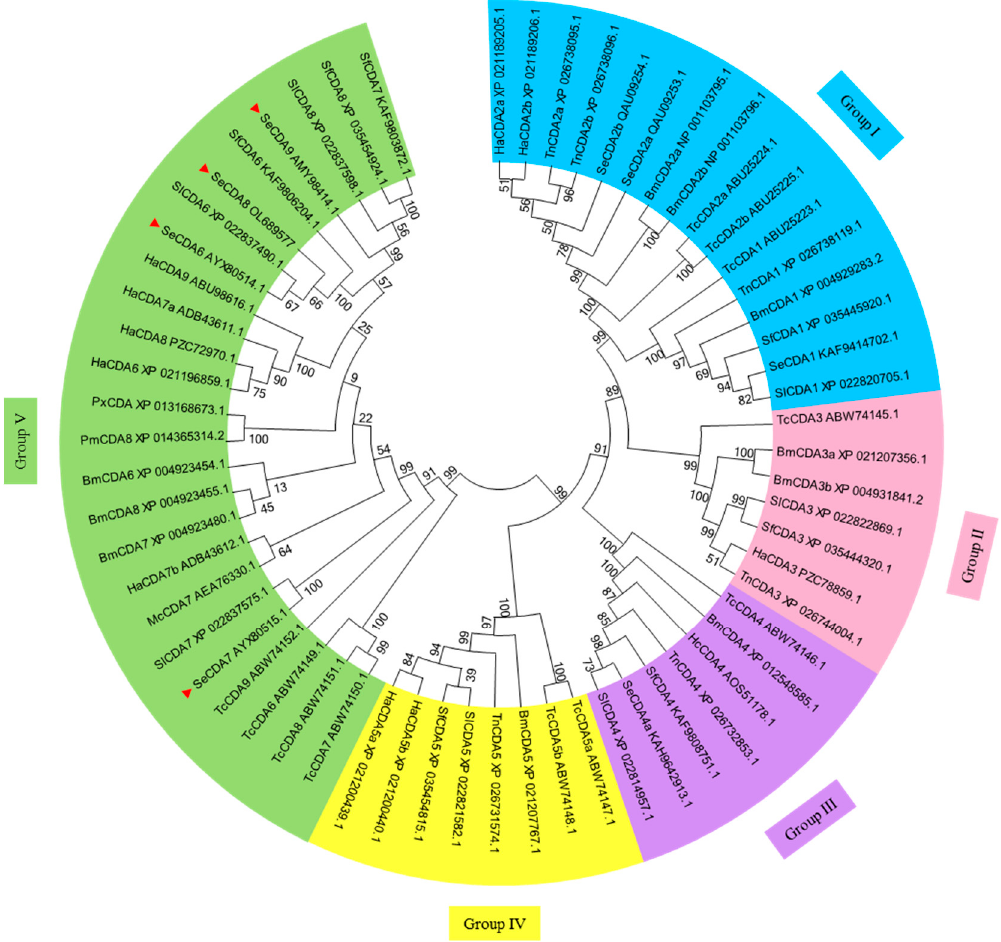
Figure 2. Phylogenetic tree of the CDA amino acid residue sequence of S. exigua and other insects. SeCDAs of S. exigua are labeled with a solid red triangle. The origin of CDA species: Bm: